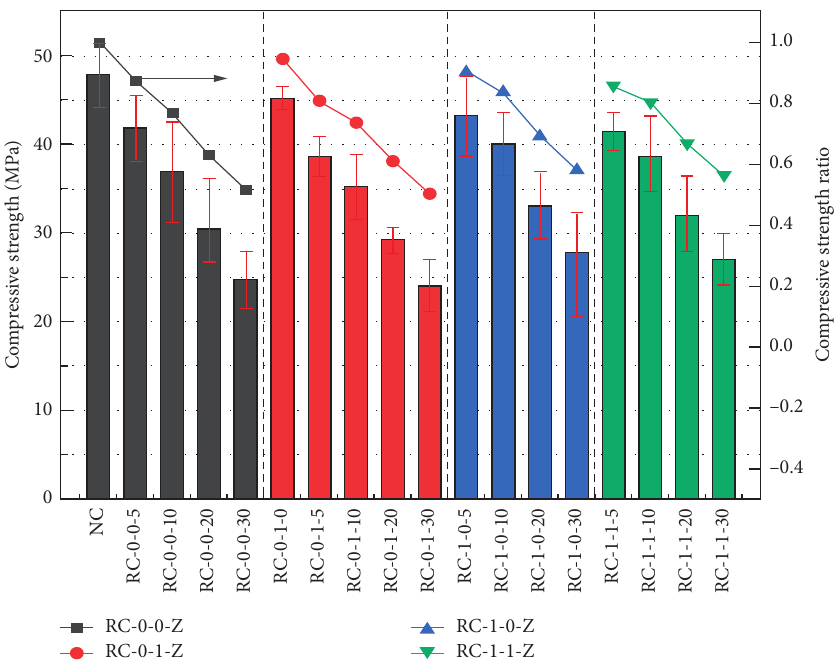
Figure 5: 28d compressive strength and compressive strength ratio.